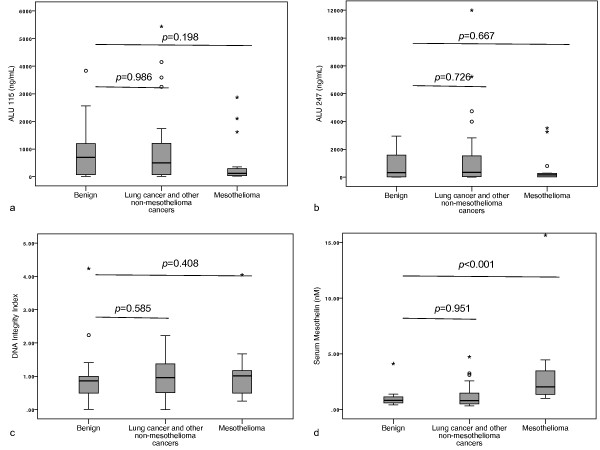
Box plots of serum DNA fragments, integrity index and mesothelin concentrations in subjects with effusions due to benign aetiology, other cancers and mesothelioma. DNA fragment values were determined by quantitative PCR for ALU (a) 115bp fragment and (b) a 247bp fragment. The DNA integrity index (c) was defined as the ratio of ALU 247/ALU 115 fragment levels. Mesothelin values (d) were determined by ELISA. Mann-Whitney U test to was used to assess for any differences in comparison to benign effusions and p values <0.05 were deemed significant.